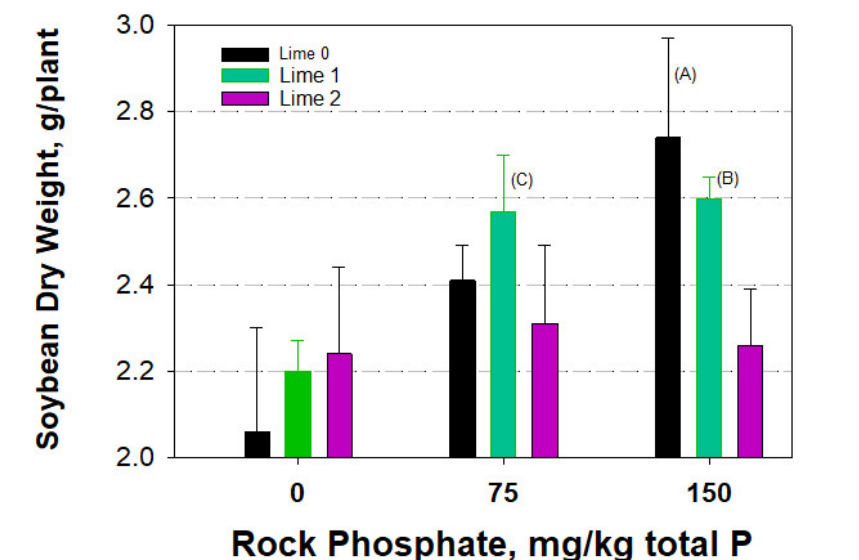
Figure 7. Shoot dry weight of soybean seedlings as affected by lime and rock P amendments. Error bars on top of larger bars are standard deviation of the measured